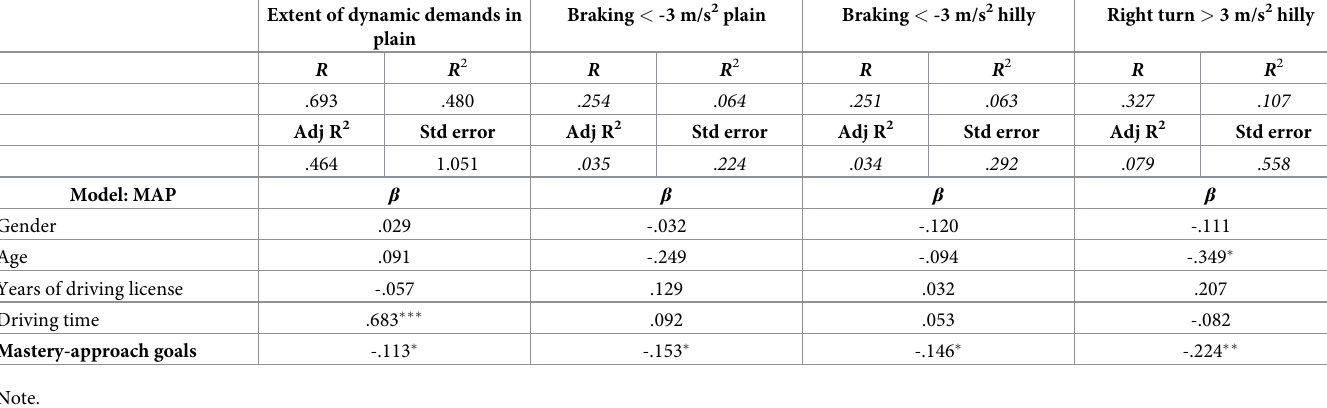
Table 3. Results of the regression analysis for mastery-approach goals with the road context.